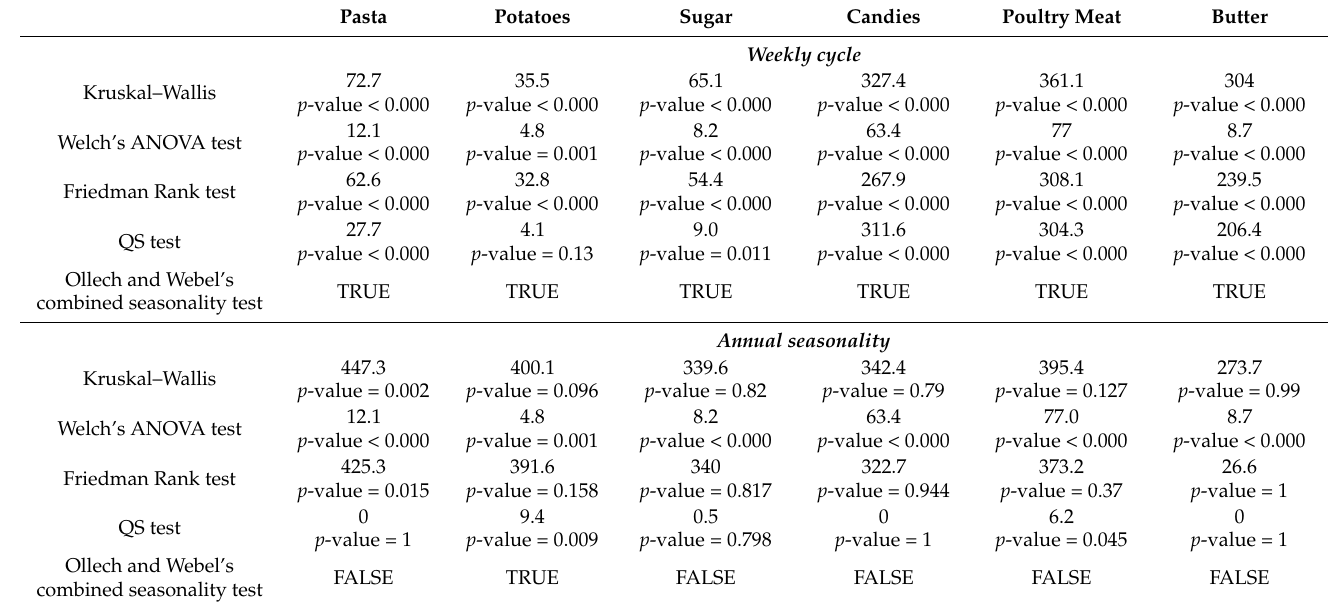
Table 4. Tests results for seasonality in spatial autocorrelation (based on binary contiguity matrix). Pasta Potatoes Sugar Candies Poultry Meat Butter Weekly cycle